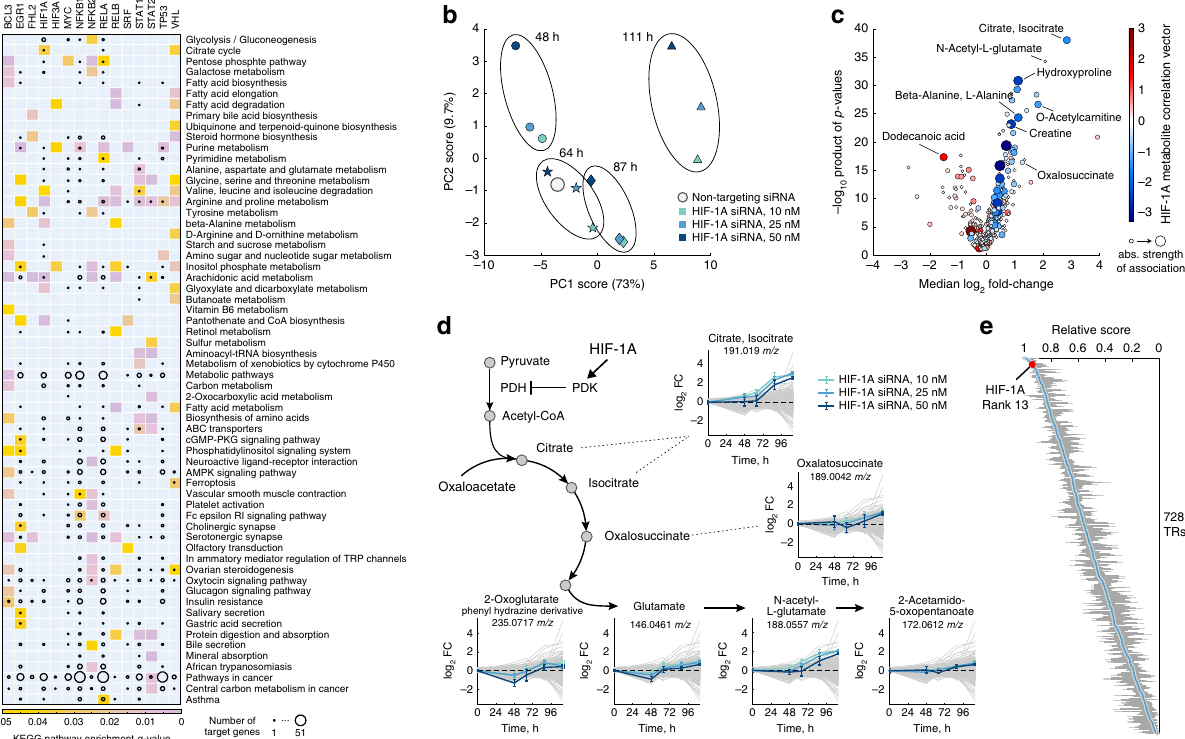
Fig. 3 Predicted functional association of TRs to metabolic pathways. a Signi fi cant over-representation in KEGG metabolic pathways for metabolites associated with 15 selected cancer-related TRs 38 (as de fi ned by the COSMIC cancer gene census). The heatmap shows metabolic pathways with a signi fi cant enrichment (hypergeometric test, q -value < 0.05). The size of black circles scales with the number of known TR-gene targets 24 in the metabolic pathway. b Principal component analysis of dynamic metabolome changes in IGROV1 ovarian cancer cells transfected with three different concentrations (10, 25, and 50 nM) of HIF-1A siRNA, and a non-targeting siRNA as negative control. c Volcano plot of metabolic changes at 111 h after HIF-1A siRNA transfection. Each putatively annotated metabolite is associated with a fold-change and signi fi cance (product of p -values across three siRNA concentrations). Only ions annotated to KEGG identi fi ers are shown. Dot size reports on the strength of the association predicted between HIF-1A activity and the metabolite in our TR-metabolite association network, while the color indicates the sign of the association. d Dynamic metabolite changes of metabolites in and proximal to TCA cycle upon siRNA transfection (with time-point 0 representing the negative control). Data are mean ± standard deviation across three replicates. Gray lines represent dynamic changes of all other detected metabolites. e The 728 TRs in the TR-metabolite association network were ranked by the median overlap of TR-metabolite associations with the metabolic pro fi les of the HIF-1A knockdown (111 h post-transfection). For each TR, we calculated a score representing the dot product of the TR-metabolite association vector and metabolite fold-changes, normalized by the sum of absolute correlations in the association network. The scores are shown as boxplots across the three siRNA concentrations (see also Supplementary Fig. 7), with blue dots indicating the median score, and edges showing 25th and 75th the most recurrent genetic events in colon and lung cancers are mutations in p53 44,45 , similarly to many different tumor types.